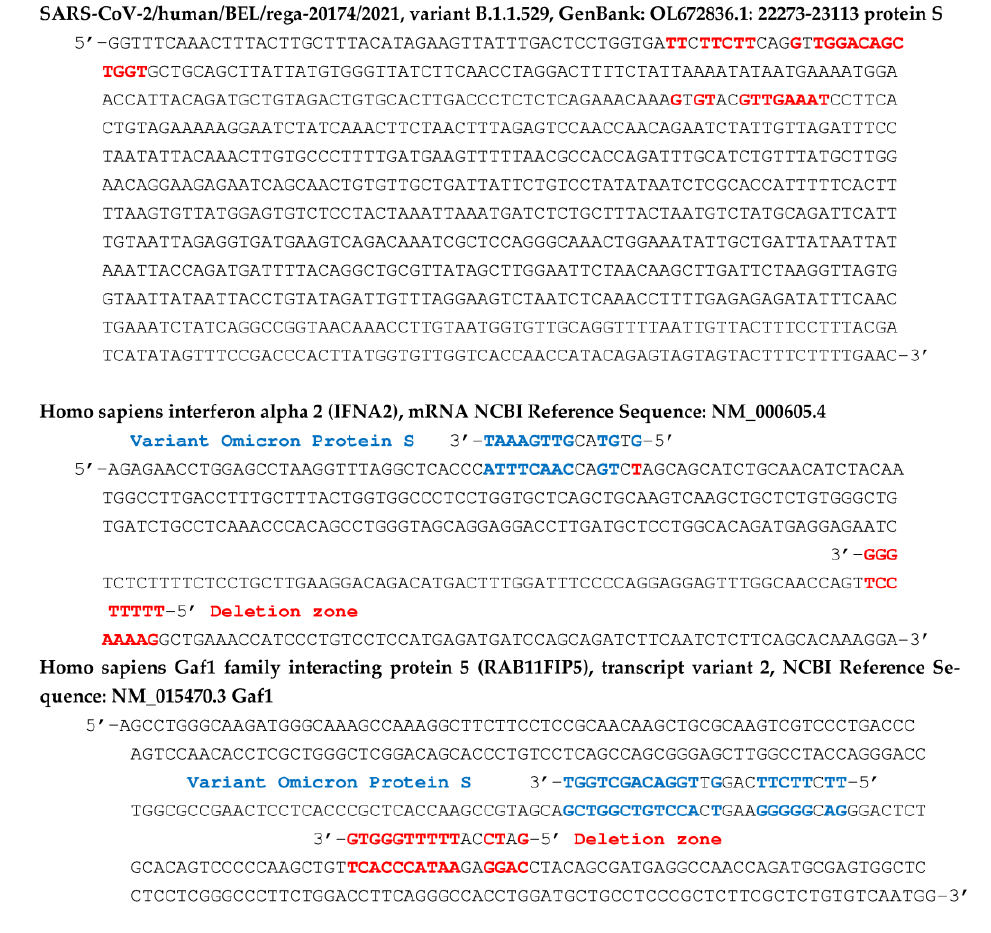
Figure 8. Top: partial sequence of the gene of S protein of the Omicron variant of the SARS-CoV-2 virus with indication (in red) of the subsequences hybridizing the human interferon gene and the anti-aging human Gaf1 gene. In the middle (respectively, bottom), the corresponding hybridization of human interferon gene (respectively, anti-aging human Gaf1 gene) by parts of the protein S gene from its deletion zone (in red) and from its variant Omicron (in blue).